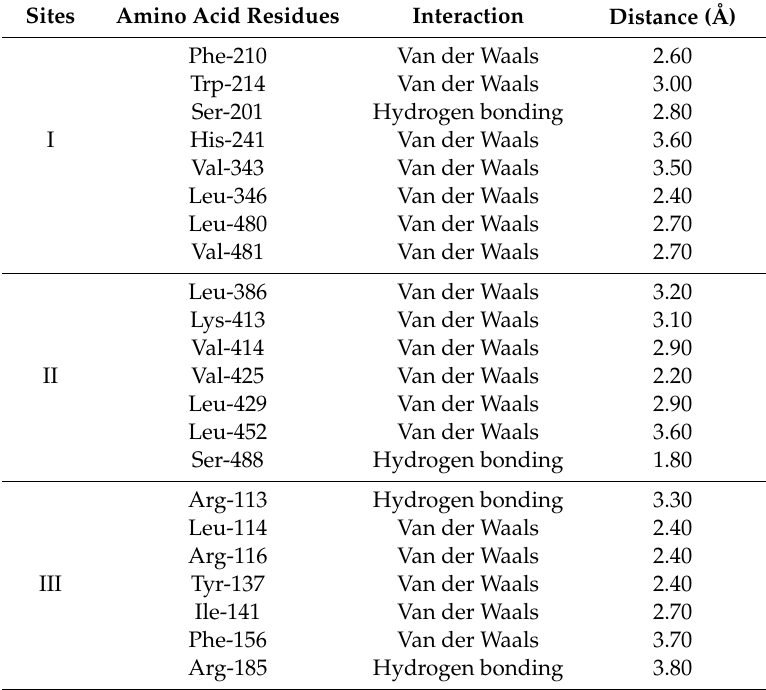
Table 4. Molecular docking results for the interaction HSA: 5e in the sites I, II and